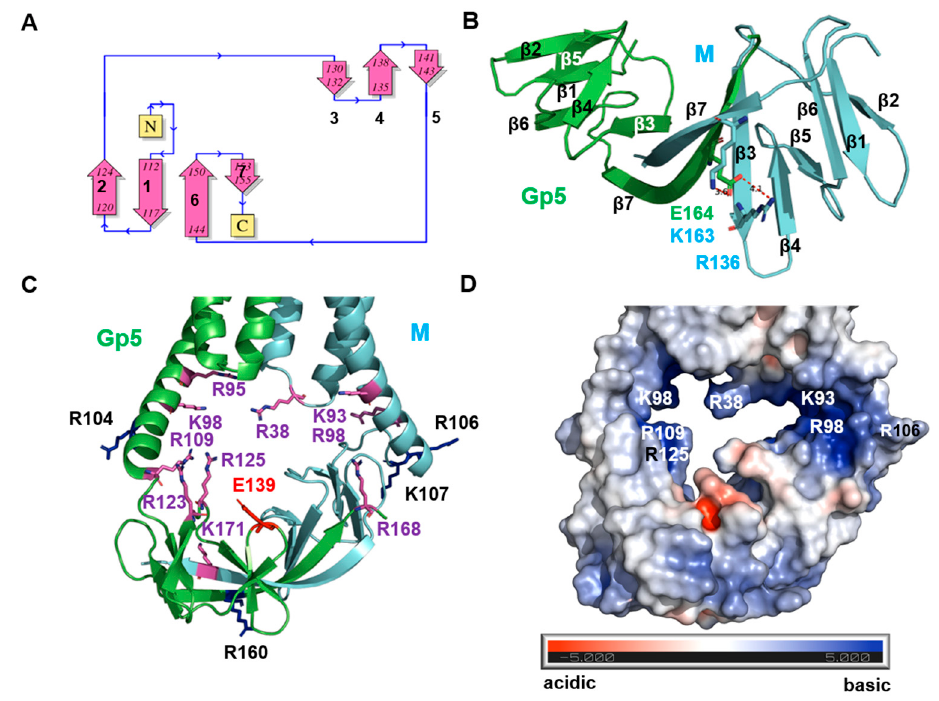
Figure 5. The structure of the endodomain of Gp5/M of PRRSV-2. ( A ) Topology sketch of the endodomain of M. β -strands 1, 2, 6 and parts of 7 build one β -sheet, and β -strands 3, 4 and 5 build another β -sheet. Note that the topology of the endodomain of Gp5 is the same. ( B ) Cartoon model of the endodomain, Gp5 in green and M in cyan. The numbering of the β -strands is indicated. Gp5 and M interact mainly via parts of β -strands 7 and via a salt bridge formed between the carboxyl group of Glu164 in β 7 of Gp5 with the amine group of Arg163 located in β 7 of M and with the guanidino group of Lys136 located in β 3 of M. ( C , D ) Cartoon representation ( C ) and electrostatic surface potential of the surface ( D ) of the cytoplasmic part of TM1 to TM3 and of the endodomains of Gp5 and M. Basic amino acids are highlighted as magenta sticks They are located in loop 1 connecting TM1 and 2 of M (Arg38) in the amphiphilic helix (Arg95, Lys98) and in the endodomain of Gp5 (Arg123, Arg125). Lys93 and Arg98 in the amphiphilic helix of M and Arg168 in the endodomain of M form another strongly basic area on the other side of the